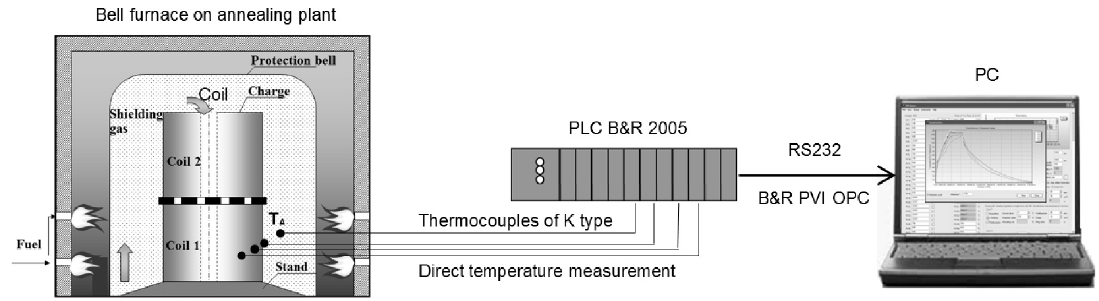
Figure 3. The scheme of measuring chain for operating